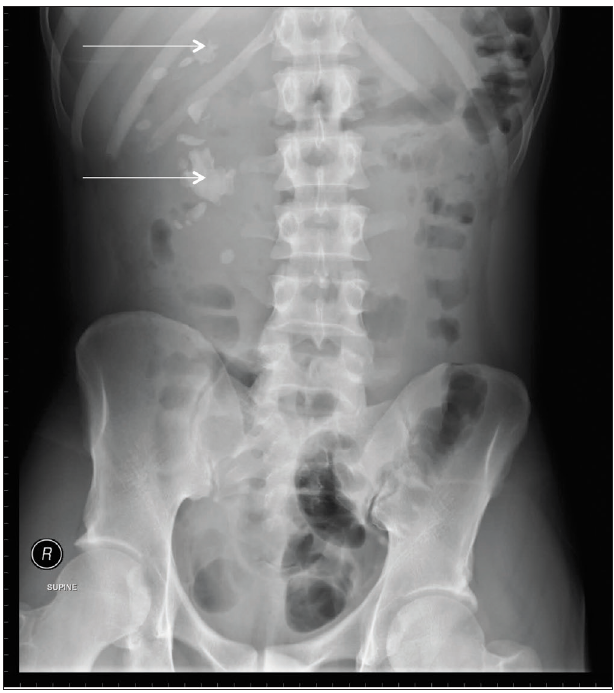
Fig. 1. Anterior X-ray demonstrating numerous well-defined densities (white arrows) projecting over the middle and upper aspects of the right abdomen.